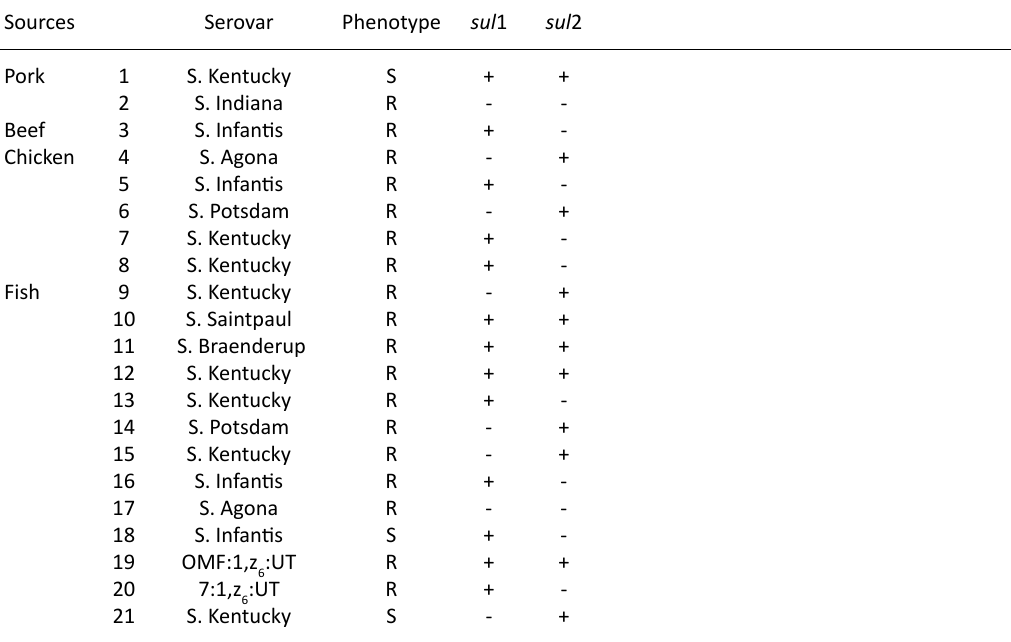
Table 5. The detection of sul 1 and sul 2 genes in serovars Sources Serovar Phenotype sul 1 sul 2